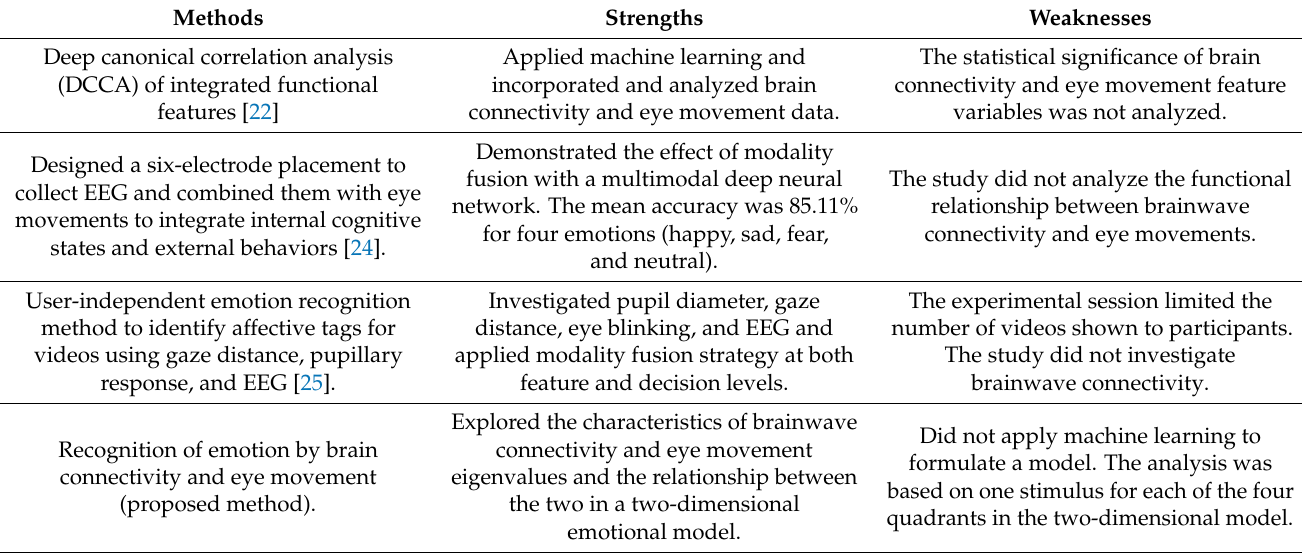
Table 1. Comparison of previous and proposed